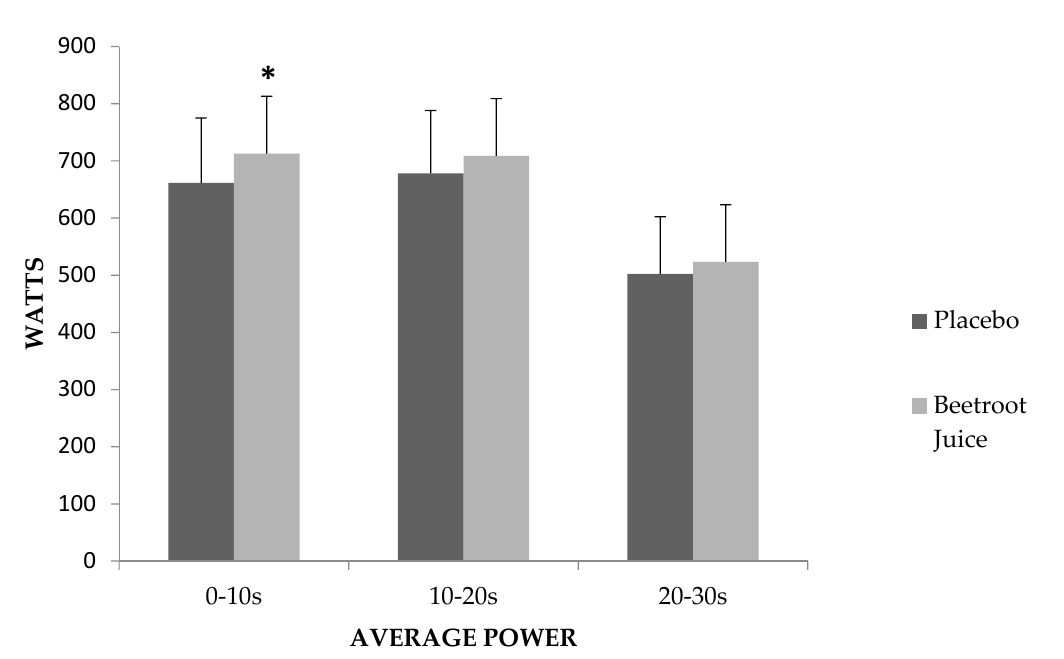
Figure 1. Average power recorded in the intervals 0–10, 10–20 and 20–30 s; * significant difference between beetroot juice and placebo ( p < 0.05).